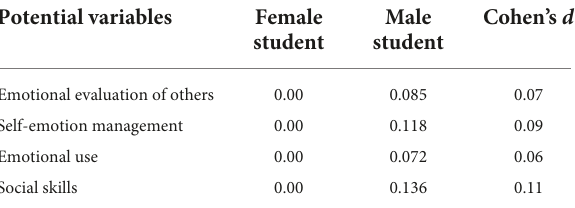
TABLE 7 Latent mean